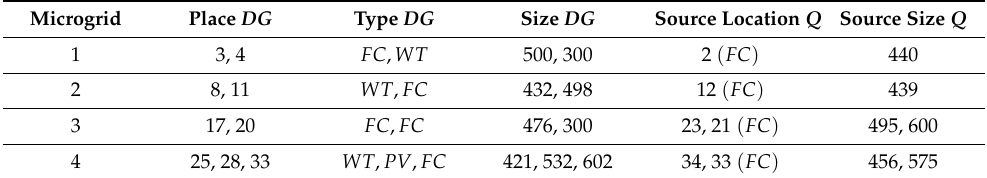
Table 3. Specifications of resources installed in the network in terms of kW and kVAr.